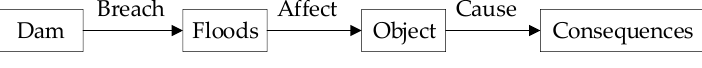
Figure 1. Logical process of dam breach consequences.